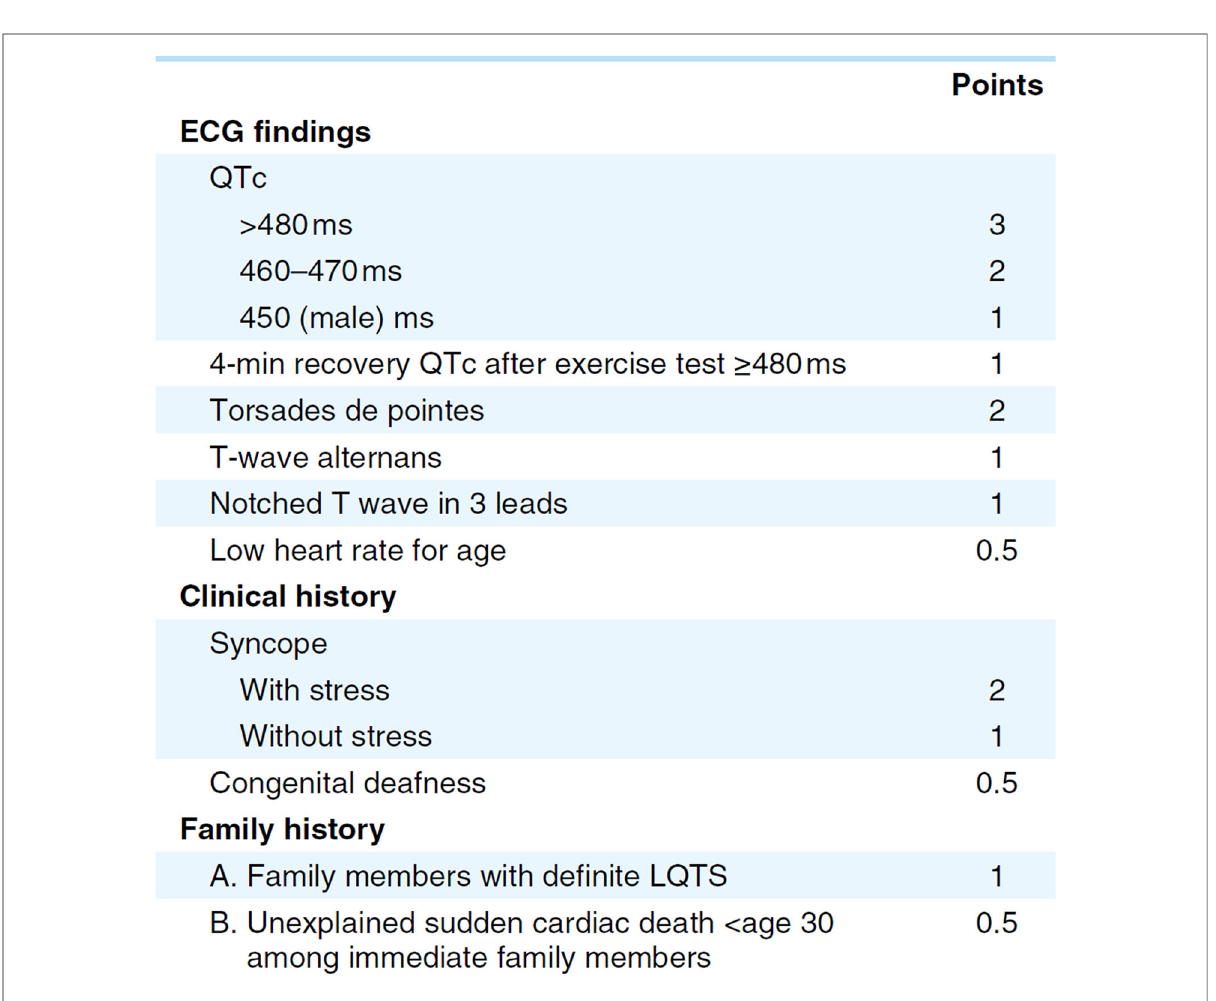
FIGURE 4 Diagnostic criteria for long QT syndrome (LQTS) (the Schwartz score). De fi nite LQTS is de fi ned by an LQTS score of ≥ 3.5